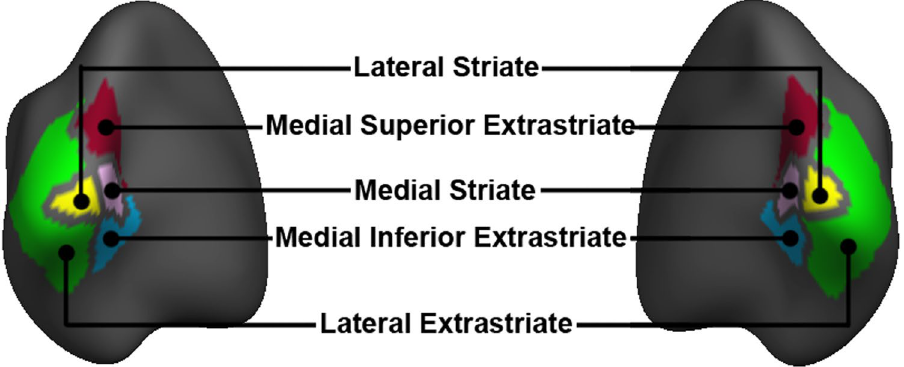
Figure 2. Control regions of interest (ROIs). Five control ROIs (5 per hemisphere) were assessed: lateral striate, lateral extrastraite, medial superior extrastriate, medial striate, and medial inferior extrastriate cortex. These ROIs were defined from the visual network splits of the Yeo resting-state atlas 17-network atlas 101 . Renderings are depicted on an MNI template from a posterior-medial-inferior viewing angle.